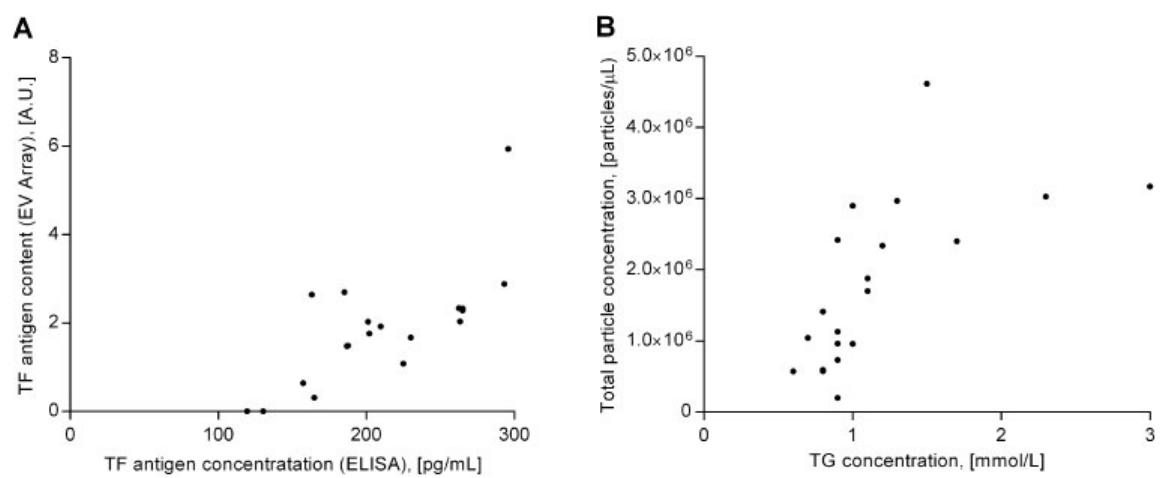
Fig. 6 ( A ) Correlation between tissue factor antigen (TF Ag) levels as measured by ELISA and EV Array in postprandial samples (Pearson ’ s r ¼ 0.73; p < 0.001). ( B ) Correlation between triglyceride (TG) concentration and total particle concentration measured by fl ow cytometry